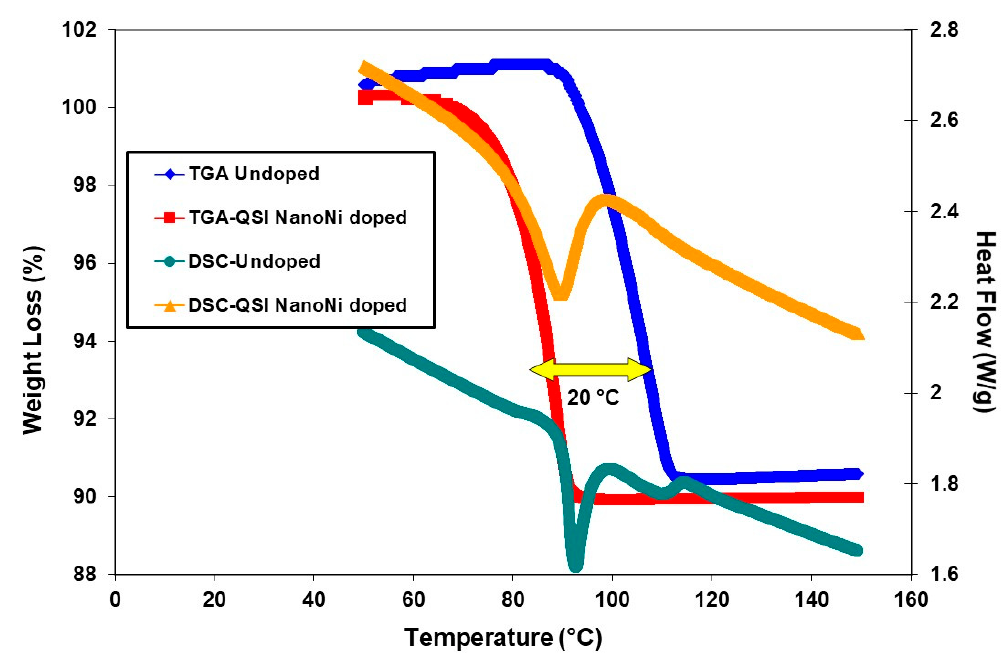
Figure 12. TGA/DSC profiles of pristine (or undoped) and nano-Ni doped Zn(BH 4 ) 2.